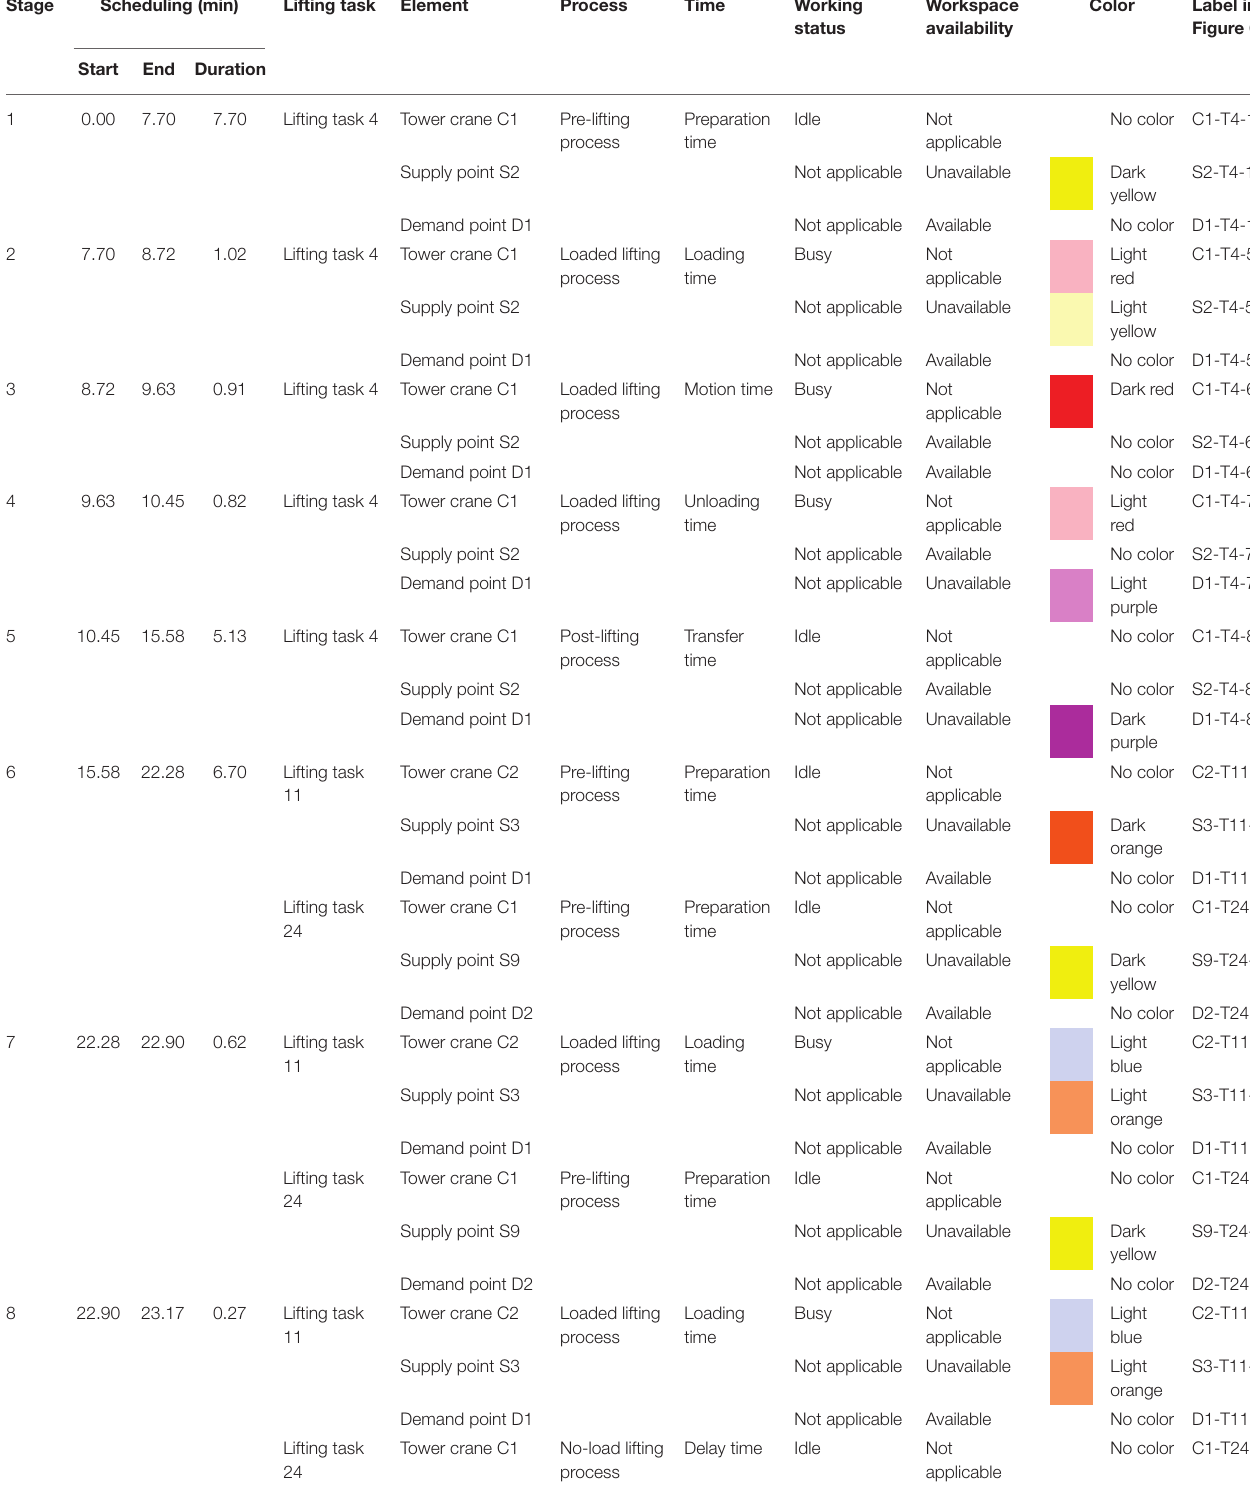
TABLE 8 | Stage information adopting the fine-level